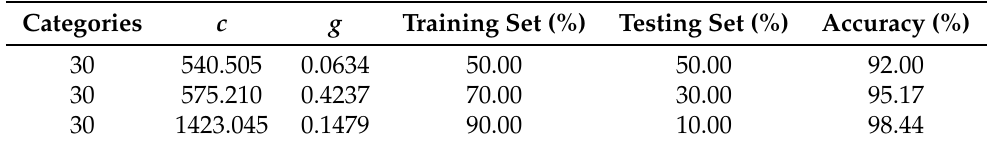
Table 7. Accuracies under different proportions of training sets and testing sets (MIT-BIH arrhythmia